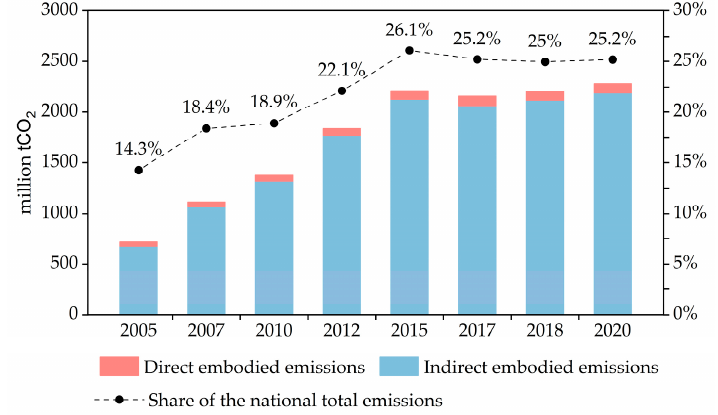
Figure 13. Total annual embodied carbon emissions of China’s building sector measured by the IO- LCA accounting model (2005–2020). IO-LCA accounting model (2005–2020).